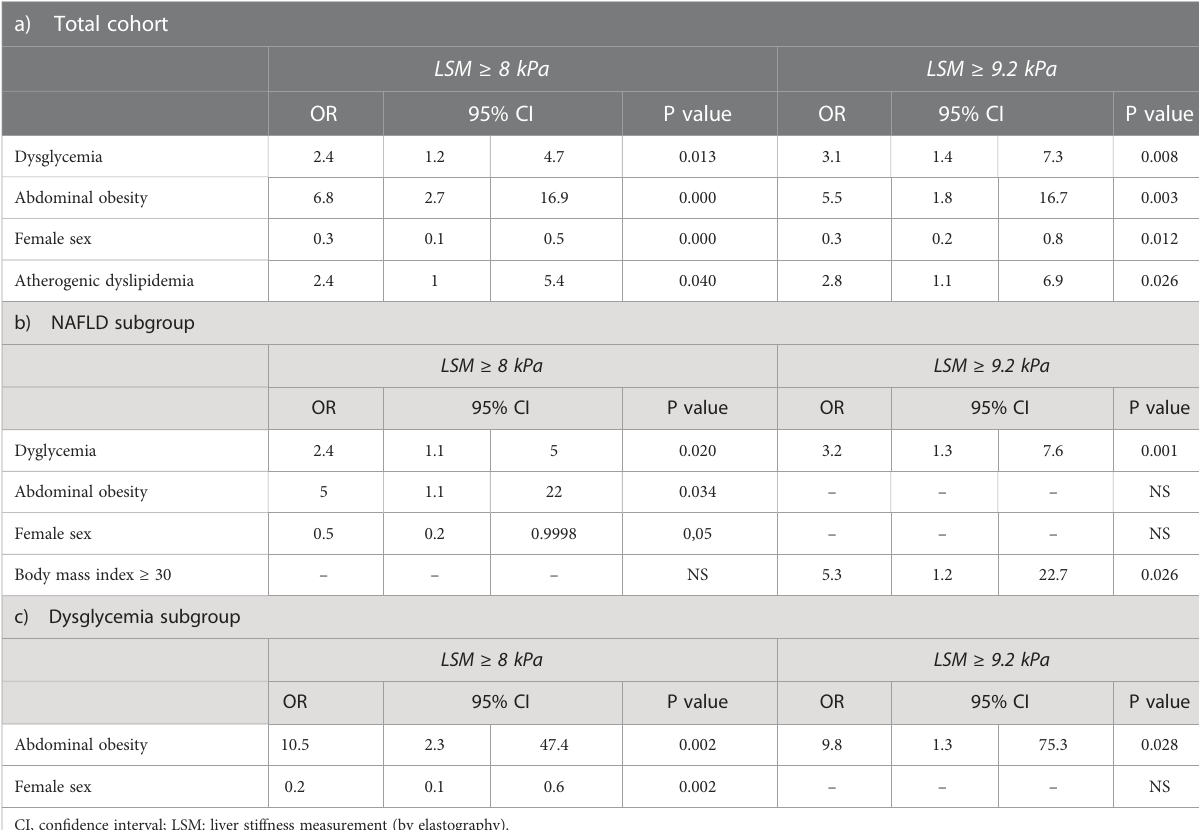
TABLE 3 Multivariate logistic regression analysis of risk factors associated with LSM ≥ 8 kPa and ≥ 9.2 kPa at